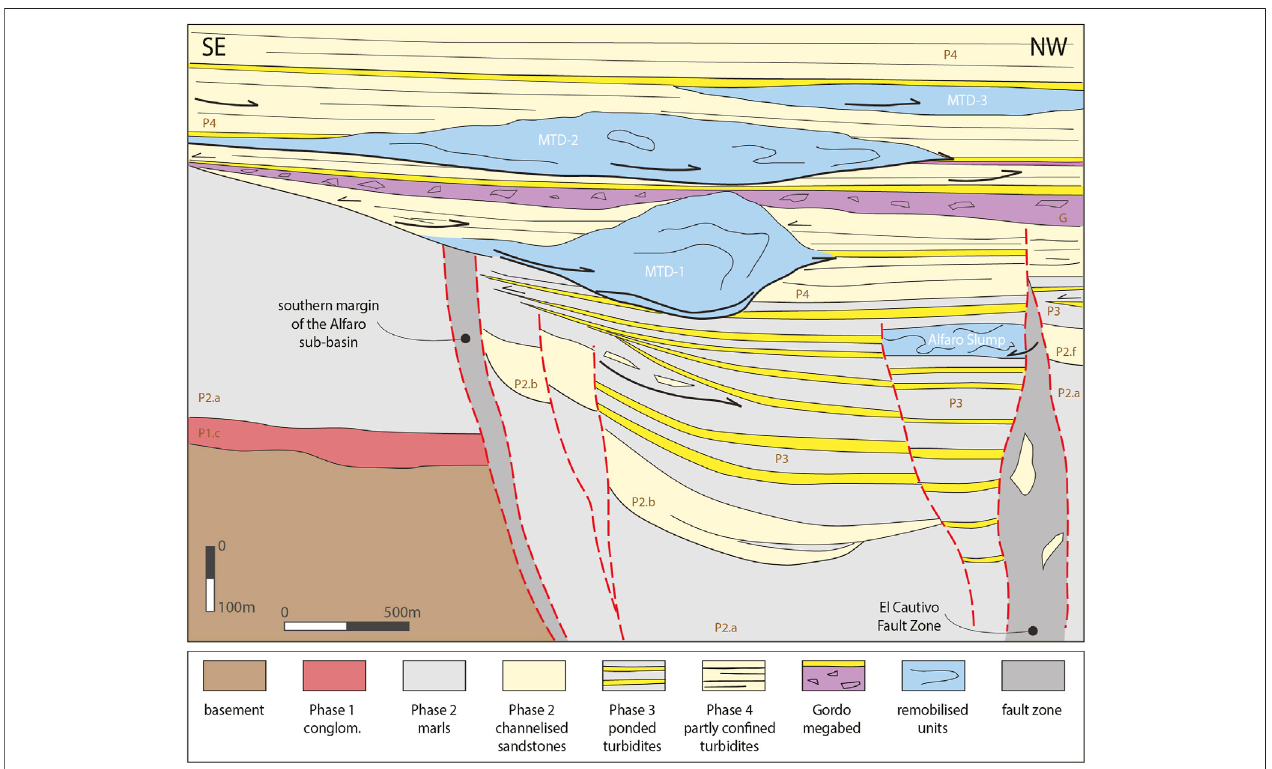
FIGURE 14 | Down-plunge schematic cross-section (vertical exaggeration of x2) of the southern part of the Tabernas Basin integrating evidence for syn- sedimentary faulting and major remobilisation described in this study and showing the inferred asymmetric character of the Alfaro sub-basin fi ll. Major detachment surfaces and displacement directions are indicated by thick dark arrows; onlap and bed pinch-outs are highlighted by thin dark arrows.